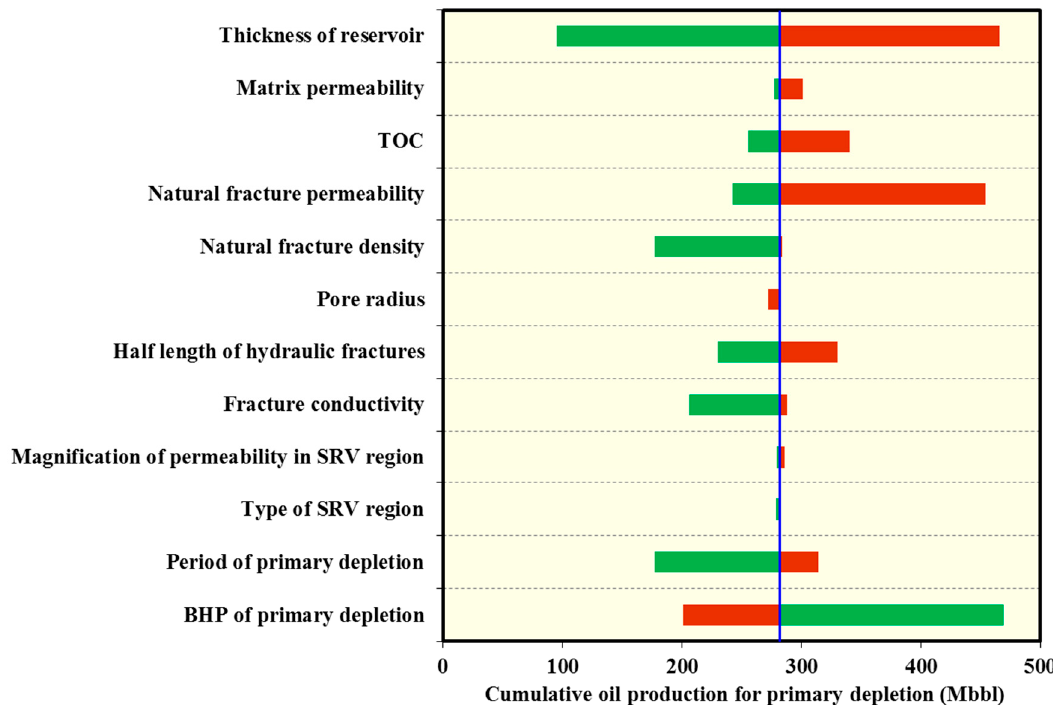
Figure 30. Tornado chart indicating the most and least sensitive parameters for cumulative oil production for primary depletion. Each green bar corresponds to a sensitivity measure (compared to a base case) when a parameter is set to its lower bound. The red bars are for the upper bounds. The vertical blue line denotes the base case.